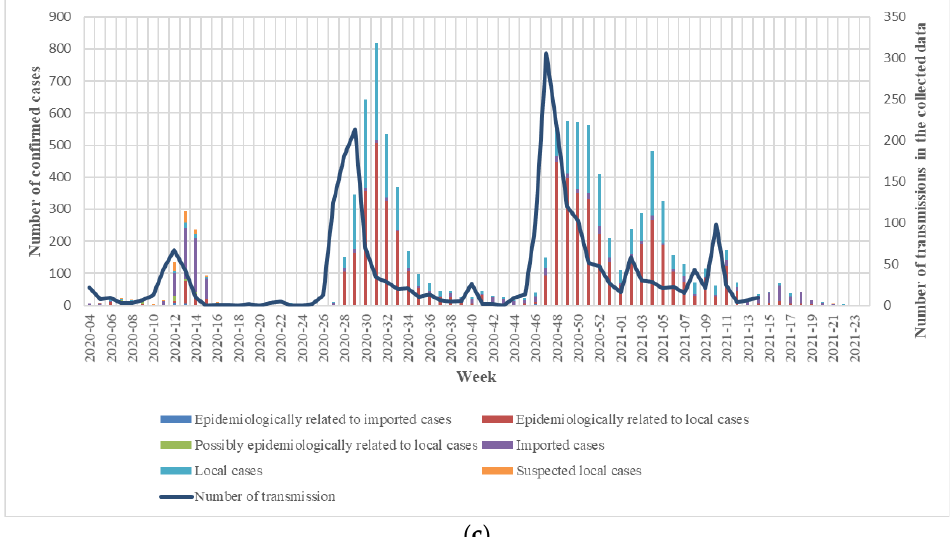
Figure 1. ( a ). TPU scale map of hong kong in the study area. ( b ). Data acquisition and analysis pro- Figure 1. ( a ) TPU scale map of hong kong in the study area. ( b ) Data acquisition and analysis process. cess. ( c ). Weekly case statistics among different waves. ( c ) Weekly case statistics among different